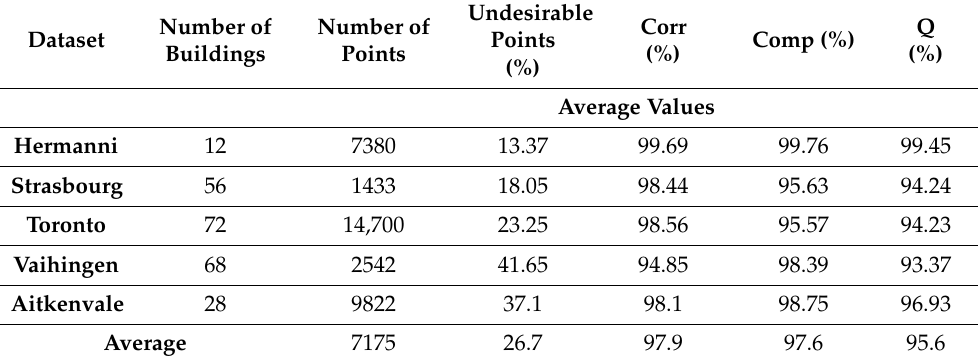
Table 3. Average values of three datasets’ filtering accuracy